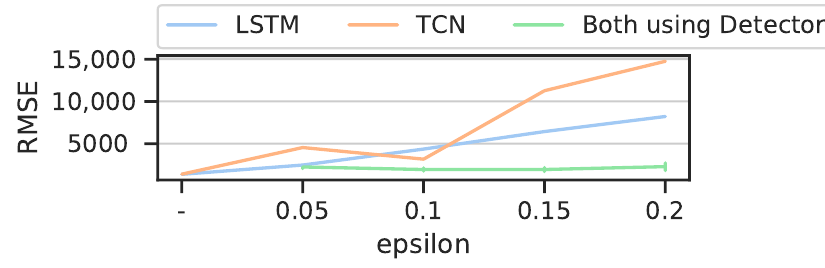
Figure 3. RMSE obtained using LSTM and TCN classifiers with and without